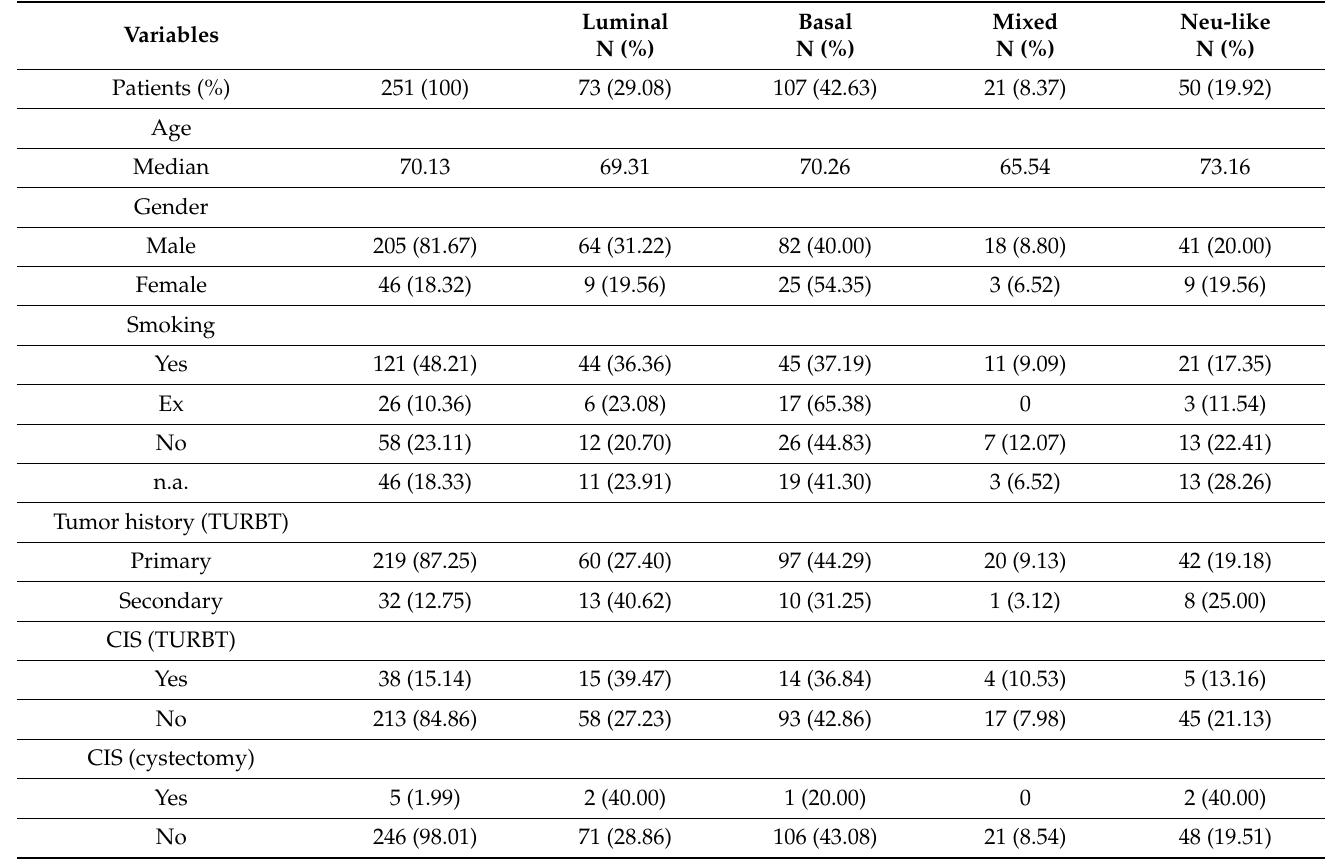
Table 1. Demographic, pathologic data of patients and phenotypical stratification in MI